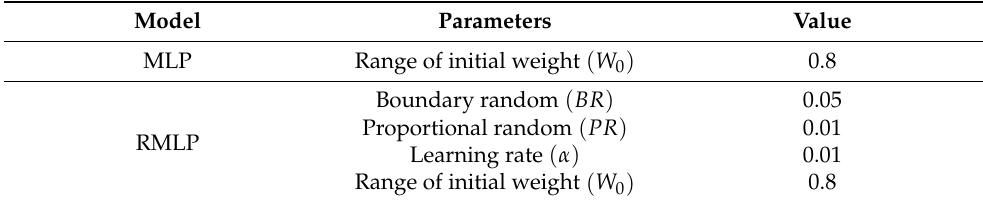
Table 6. Result of model parameter